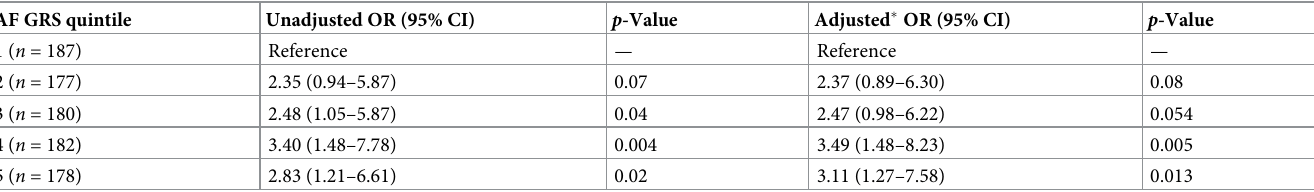
Table 3. Risk estimates of AF events according to AF GRS quintile (12